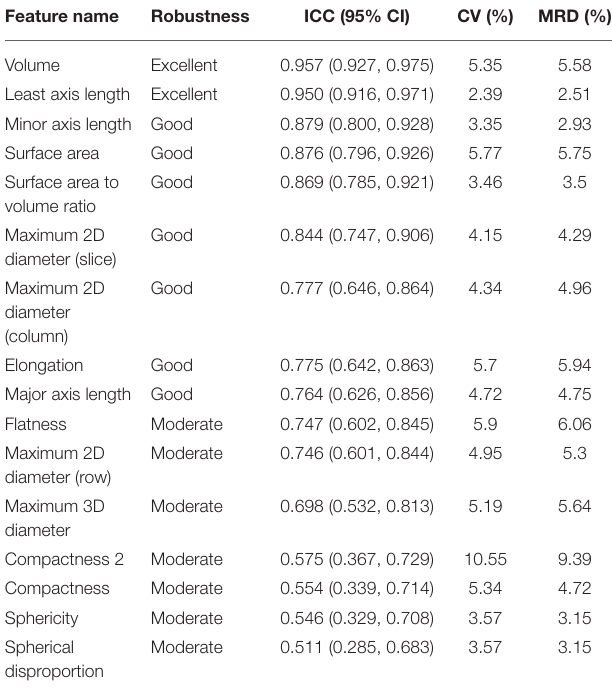
TABLE 2 | Repeatability of left ventricular blood pool shape features in